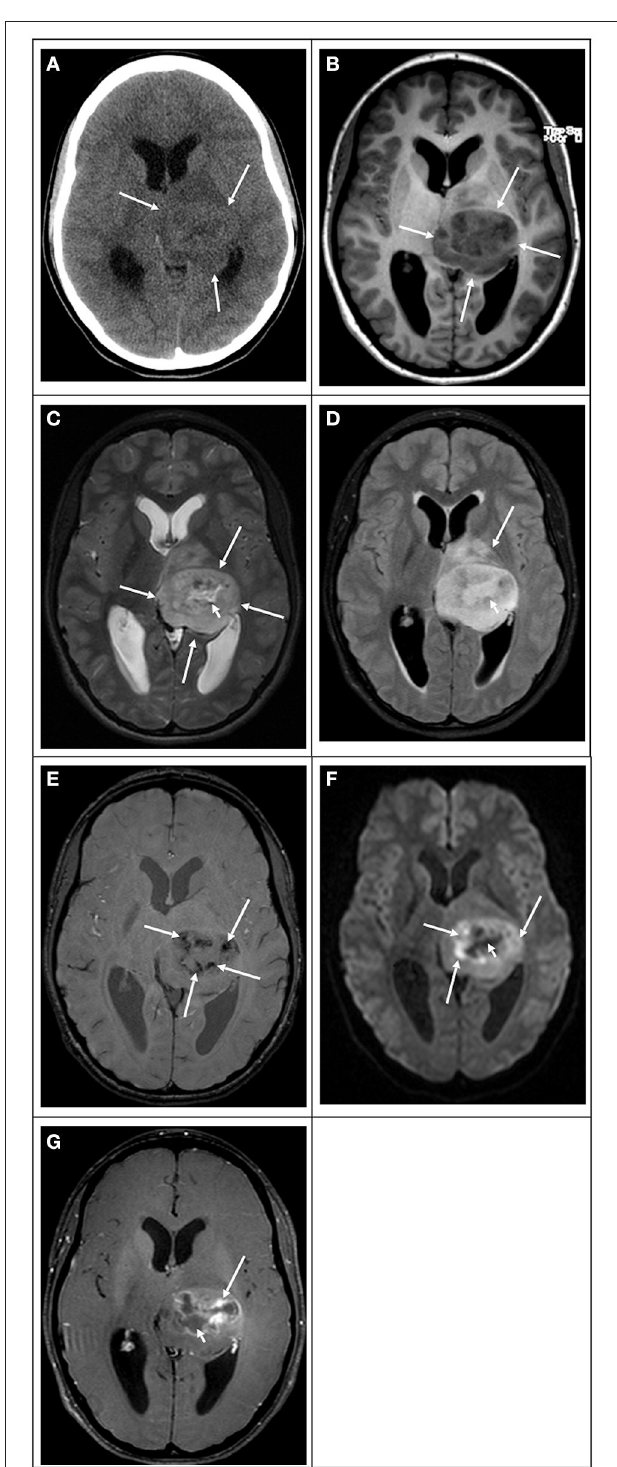
FIGURE 9 | 13-year-old female with blurry vision, facial weakness, and right-sided paresthesias due to a left thalamic glioblastoma. (A) Computed tomography image in the axial plane shows an ill-defined slightly hyperdense mass in the left thalamus. (B) T1 weighted image in the axial plane shows that